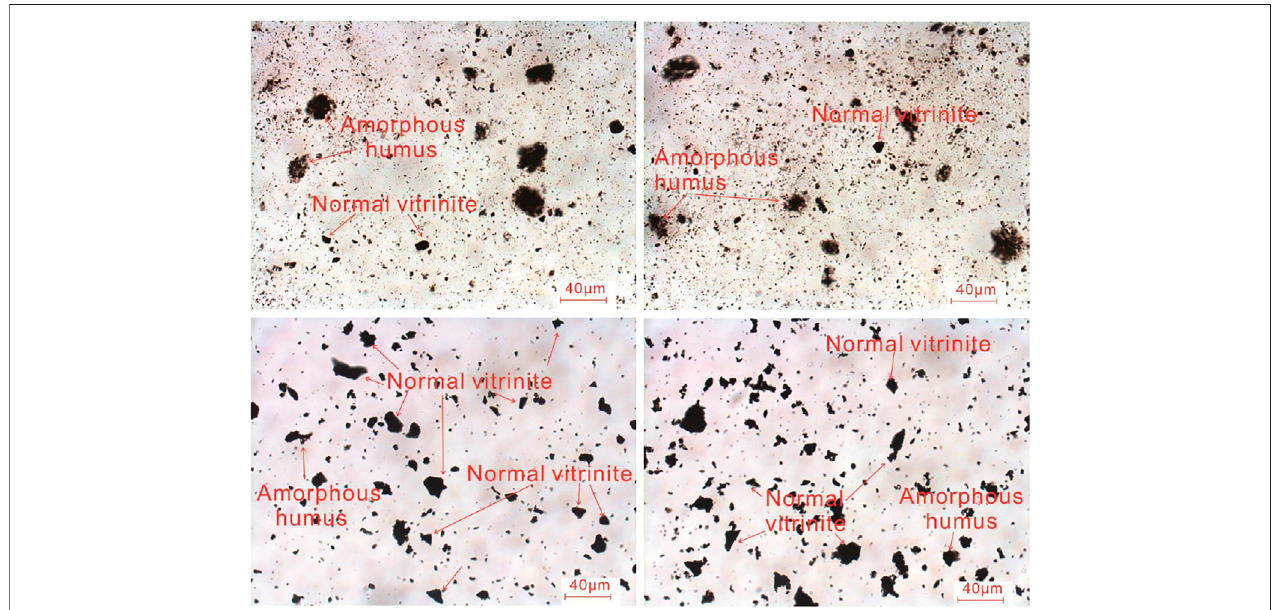
FIGURE 3 | Light sheet fl uorescence photos of typical samples of Longtan Formation shale.